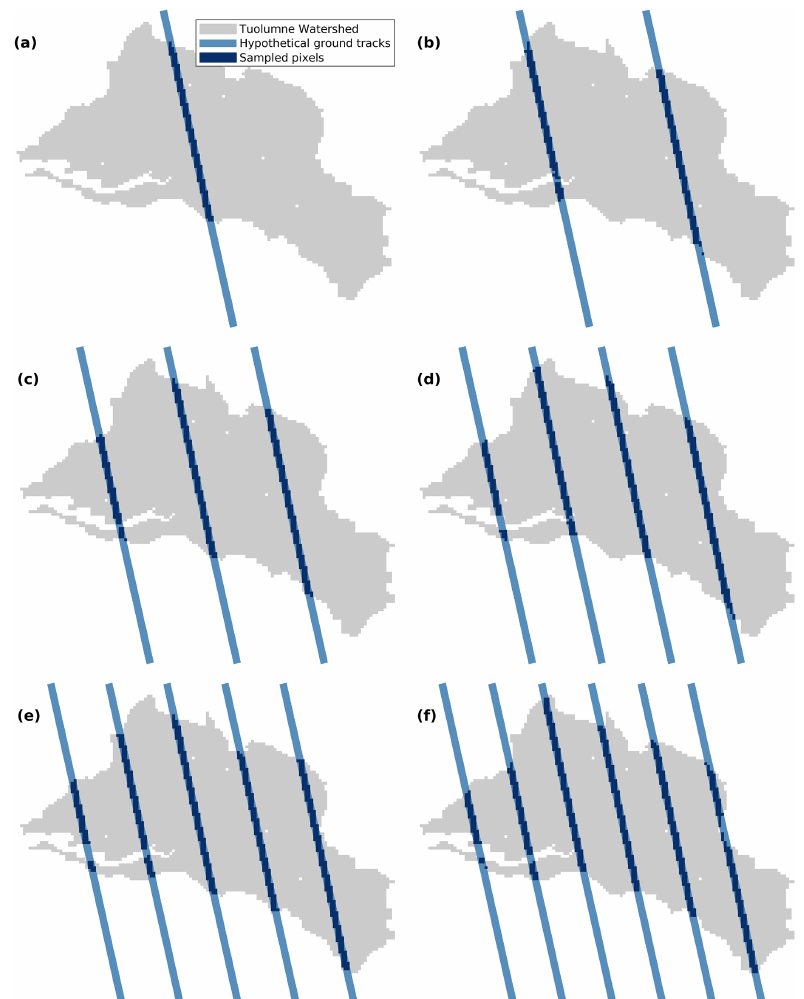
Figure 10. Illustration of the 1–6 ( a–f , respectively) hypothetical ground tracks in the upper Tuolumne watershed. The distance between each track is roughly the same over the whole